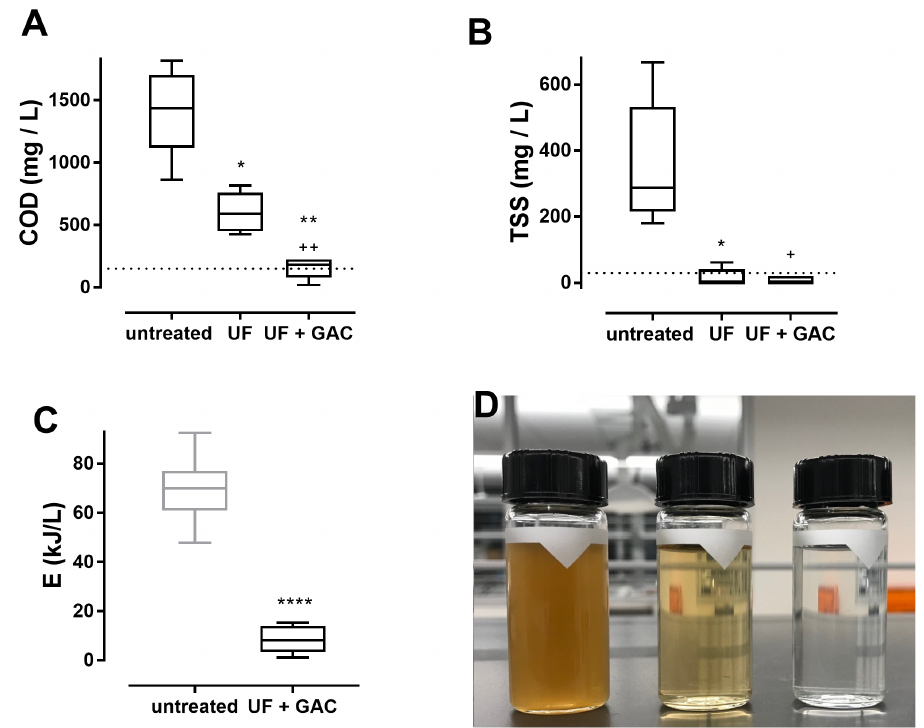
Figure 1. Pilot study combining ultrafiltration (UF) and granular activated carbon (GAC). A and B : improvements in chemical oxygen demand (COD) and total suspended solids (TSS), respectively, with UF followed by GAC. Data are n = 5 batches, measurements taken sequentially in each batch. Dotted lines indicate ISO 30500 category B standards (150 mg/L COD and 30 mg/L TSS). Significance determined by repeated measures one-way ANOVA with a Tukey’s multiple comparisons test. * = adjusted p < 0.05 vs. untreated, ** = adjusted p < 0.01 vs. untreated, + = adjusted p < 0.05 vs. UF, ++ = adjusted p < 0.01 vs. UF. C : Comparison of energy required to achieve disinfection (MPN < 5/ml) of blackwater treated by UF and GAC prior to electrochemical disinfection (n=5) to untreated blackwater (n=18). Untreated data are from a previous study 3 . Significance determined by two-tailed t-test, **** = p < 0.0001. A – C : lines indicate median, boxes 25 th and 75 th percentiles, error bars maximum and minimum values. D : Samples of untreated, UF treated, and UF + GAC treated blackwater (left to